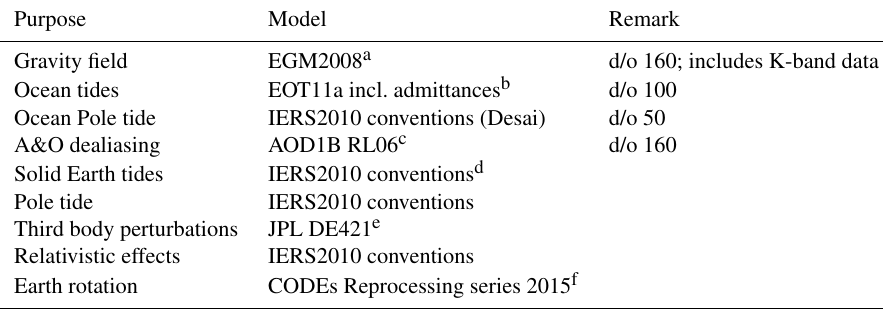
Table 1. Models used for the full a priori force field. Purpose Model Remark Gravity field EGM2008 a d/o 160; includes K-band data Ocean tides EOT11a incl. admittances b d/o